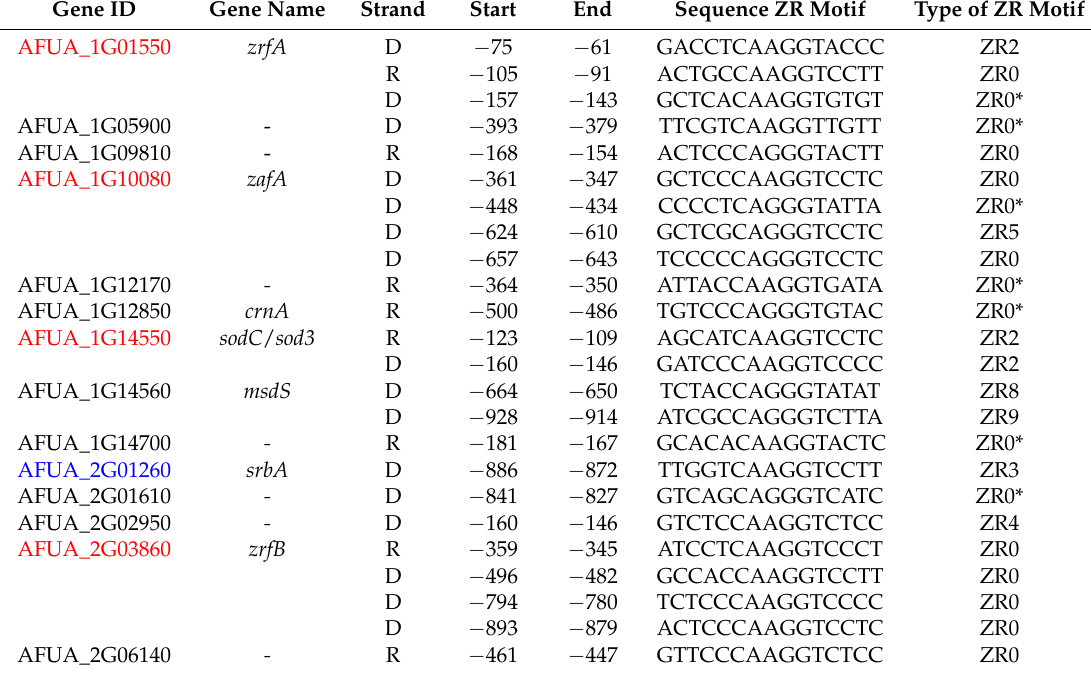
Table 3. Genes regulated or that were predicted to be regulated by ZafA. The expression of genes in red and blue was shown to be induced and repressed respectively by ZafA, as confirmed by RT-qPCR and/or northern-blot. The expression of genes in black and green was predicted to be induced and repressed respectively by ZafA. Start and end positions of the ZR motifs were numbered taking as reference that the base preceding the A nucleotide of the ATG translation start codon is at position − 1. Motifs labeled with an asterisk (*) had two substitutions with respect to the ZR consensus motif out of the hexanucleotide core sequence 5 ′ -CARGGC-3 ′ (ZR0*).